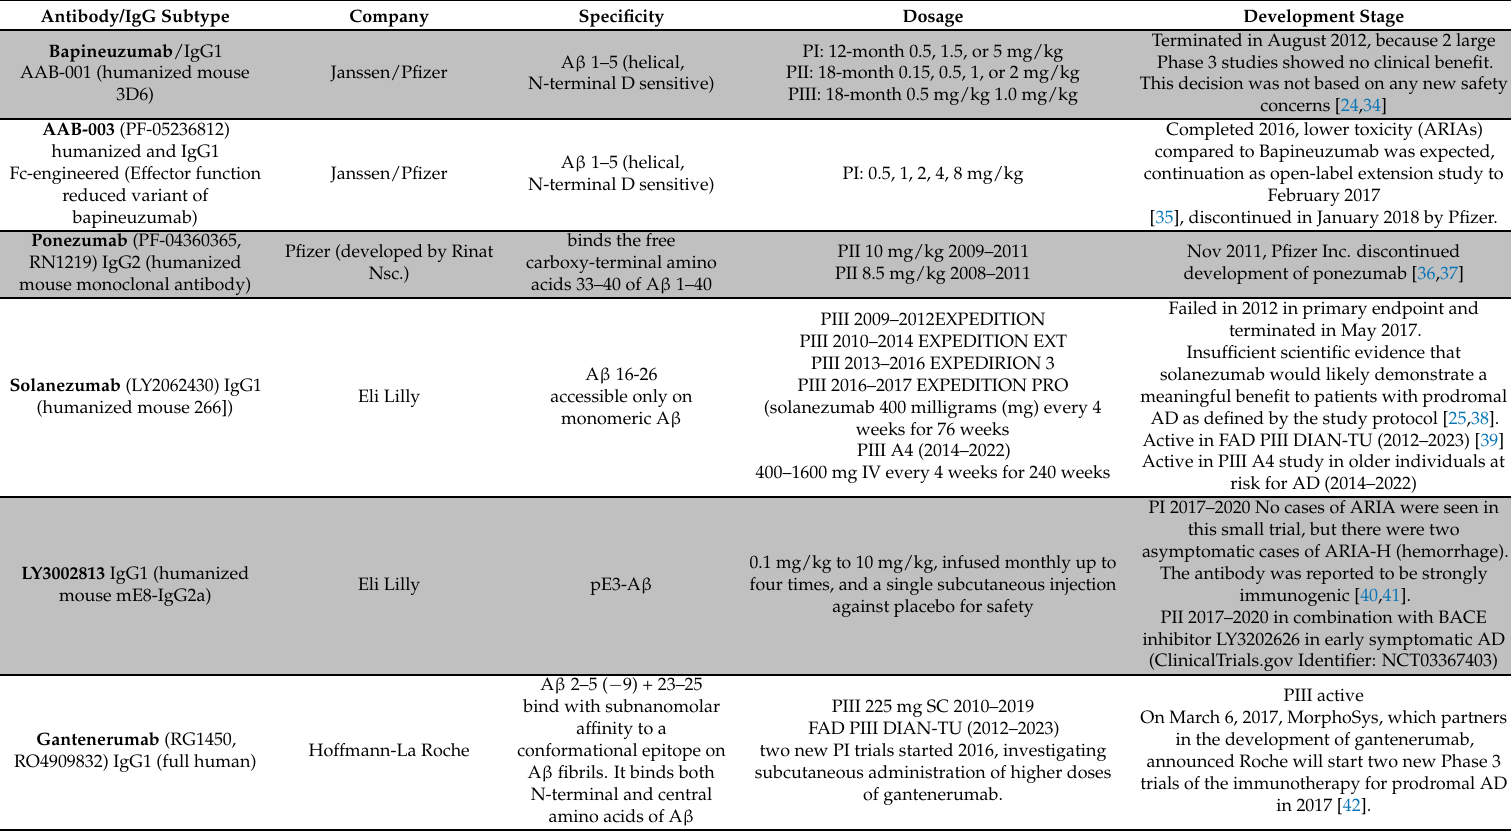
Table 1. Overview of amyloid β (A β )-directed antibodies being tested in clinical trials. Further information can be found on https://clinicaltrials.gov/. PI, PII, and PIII refer to phases one, two, and three of clinical trials, respectively. AD: Alzheimer’s disease; ARIA: amyloid-related imaging abnormality; FAD: Familial Alzheimer’s Disease; IV: intravenous; SC: